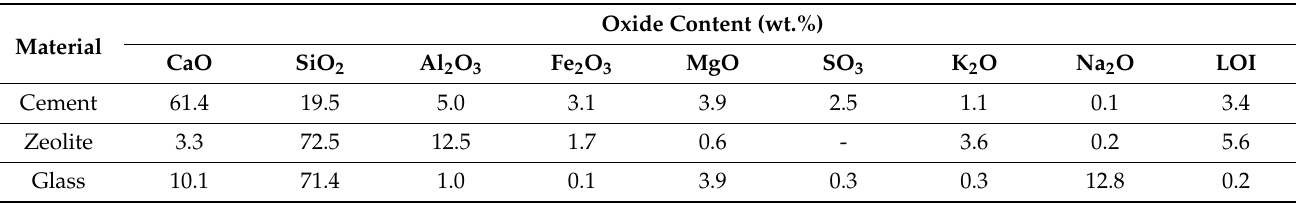
Table 1. Chemical compositions of cement, natural zeolite and soda lime glass. Oxide Content Material